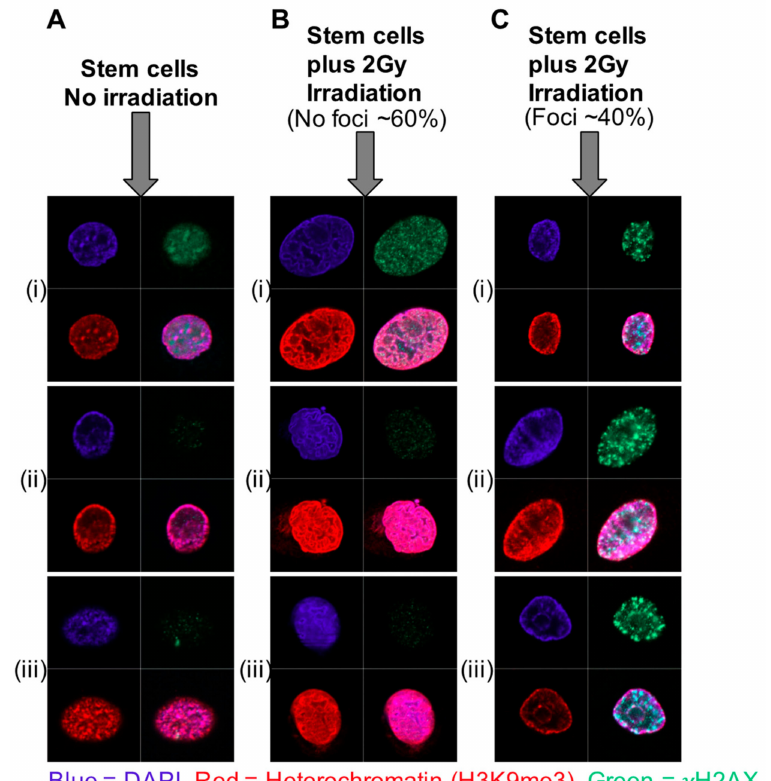
Figure 3. Nuclear architecture and foci of DNA repair in prostate epithelial cell subtypes. Primary prostate epithelial cells were cultured and separated into stem cells (SCs), transit amplifying cells (TAs) and committed basal cells (CBs). Each cell population was irradiated with 2Gy irradiation and cells were fixed and stained 30 min post-irradiation for nuclear stain (DAPI) (blue) heterochromatin (H3k9me3) and γ H2AX (green). Unlike TA and CB cells, where the majority of cells (~80%–95%) showed DNA damage ( γ H2AX foci) post-irradiation, only ~40% of SC were positive for foci. This trend was observed in 13 BPH (benign prostatic hyperplasia) samples and 15 prostate cancer samples. The SCs that were negative for foci had a distinctive heterochromatin pattern. In the SCs that were positive for foci, the foci did not coincide with the regions of heterochromatin. Images represent ( A ) unirradiated stem cells with no foci, ( B ) irradiated stem cells with no foci (60% of cells) and ( C ) irradiated stem cells with foci (40% of cells). Three examples of each group are shown (i), (ii) and (iii)